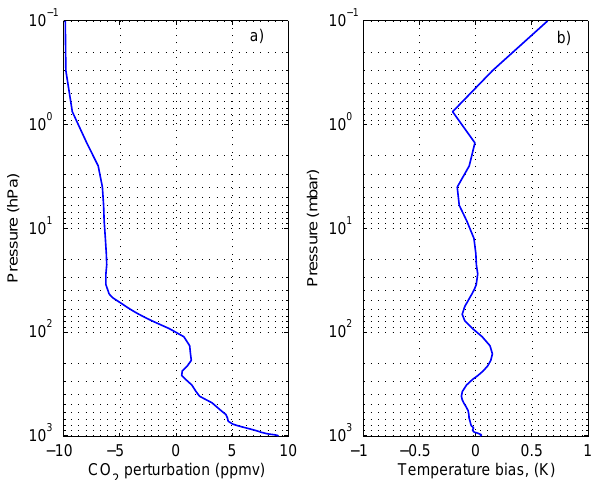
Fig. 16. The sensitivity of the retrieved temperature profile to a non correct specification of the CO 2 mixing ratio profile. Panel (a) ) shows the difference between the assumed CO 2 profile and the true profile. Panel (b) shows how the differences shown in panel (a) would bias the inverted temperature